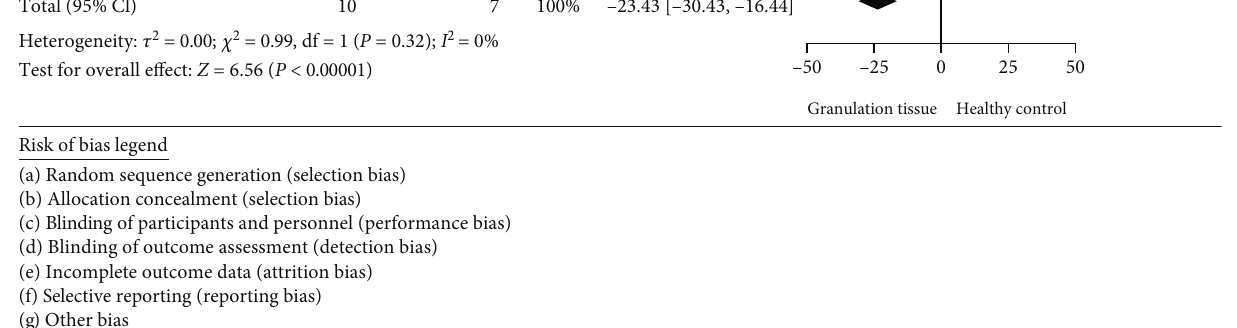
Figure 2: Summary forest plot for the comparison of the expression of CD90 from granulation tissue and healthy control. The random e ff ect, mean di ff erence weighted pooled analysis was used for the assessment. CI: con fi dence interval.